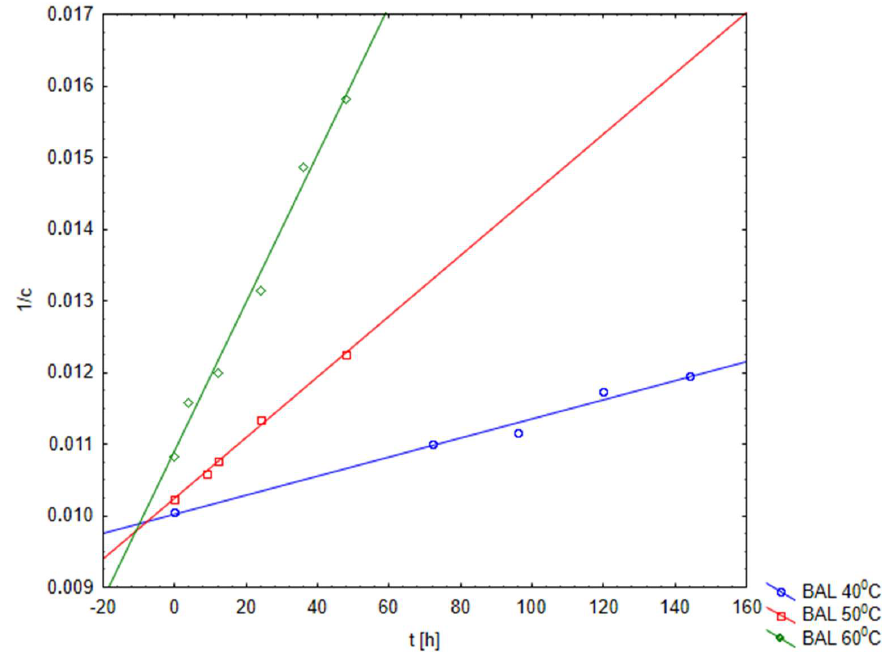
Figure 11. The 1/c = f(t) graph of oxidation of BAL under the influence of ACVA. Figure 11. The 1 / c = f(t) graph of oxidation of BAL under the influence of